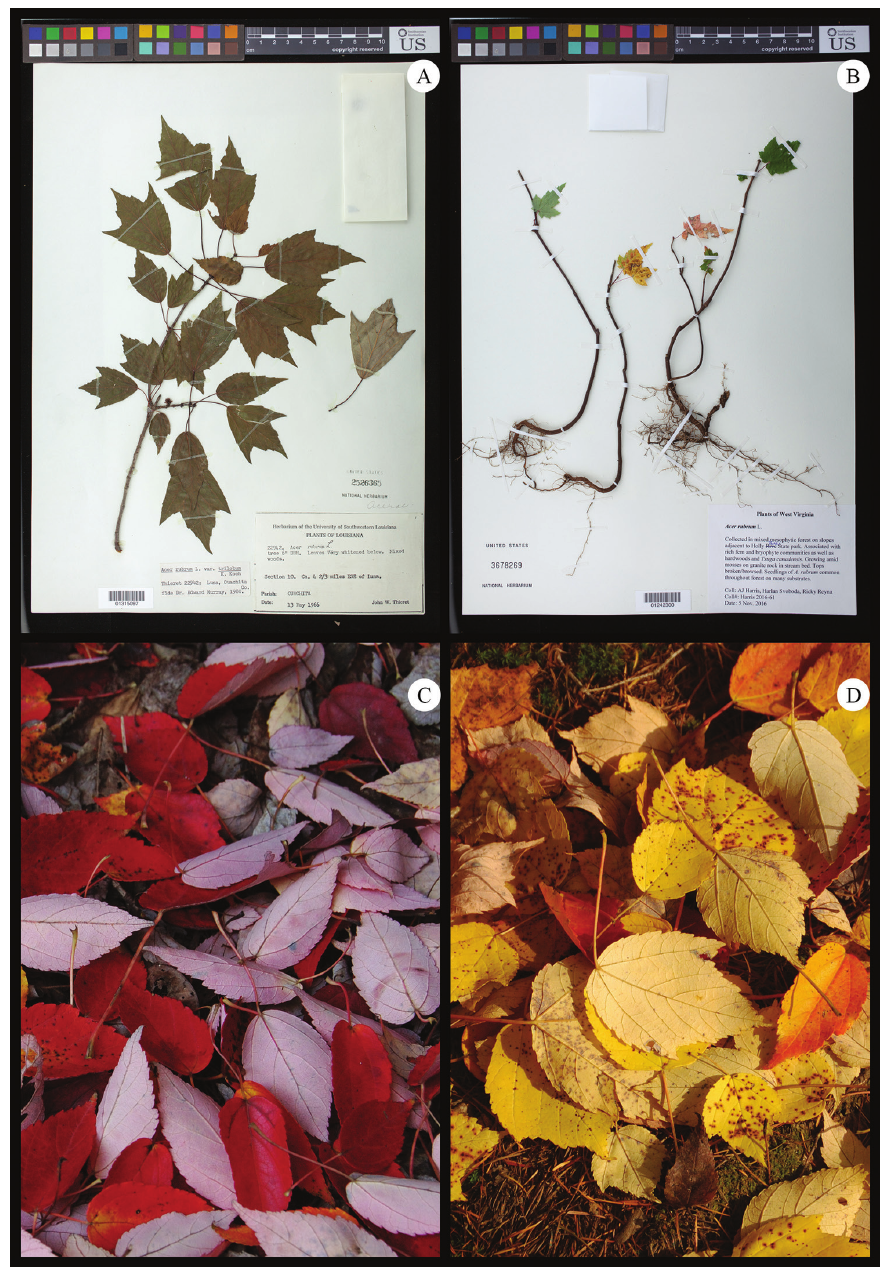
Figure 8. Elongate leaf shape in Acer rubrum and A. pycnanthum . A–B A. rubrum C–D A. pycnanthum . Unfortunately, there is no scale for the images of A. pycnanthum , but the leaf size is similar to that illus- trated in Figure 1B. Herbarium specimens in A and B deposited at US, and accession information visible in images. Detailed specimen records are available via the US online catalog (http://collections.nmnh.